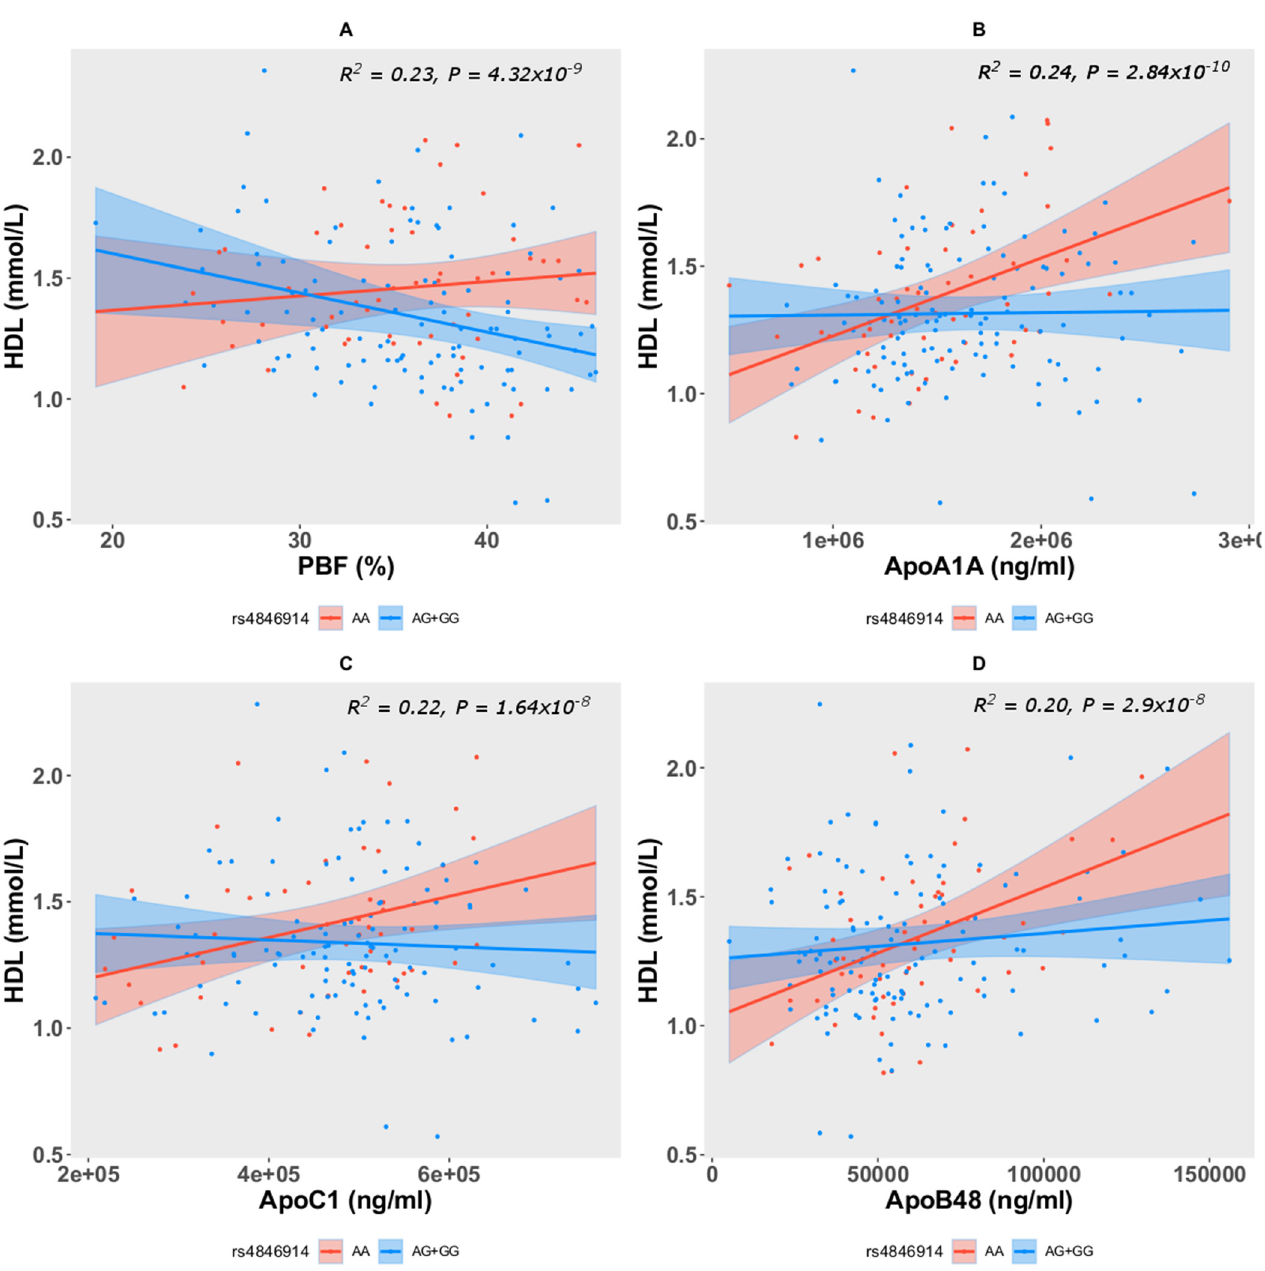
Figure 5. Interactions observed in HDL with PBF (negative correlation) ( A ), ApoA1A ( B ), ApoC1 ( C ), and ApoB48 ( D ) in interaction with the AG+GG carrier genotype at the study variant.